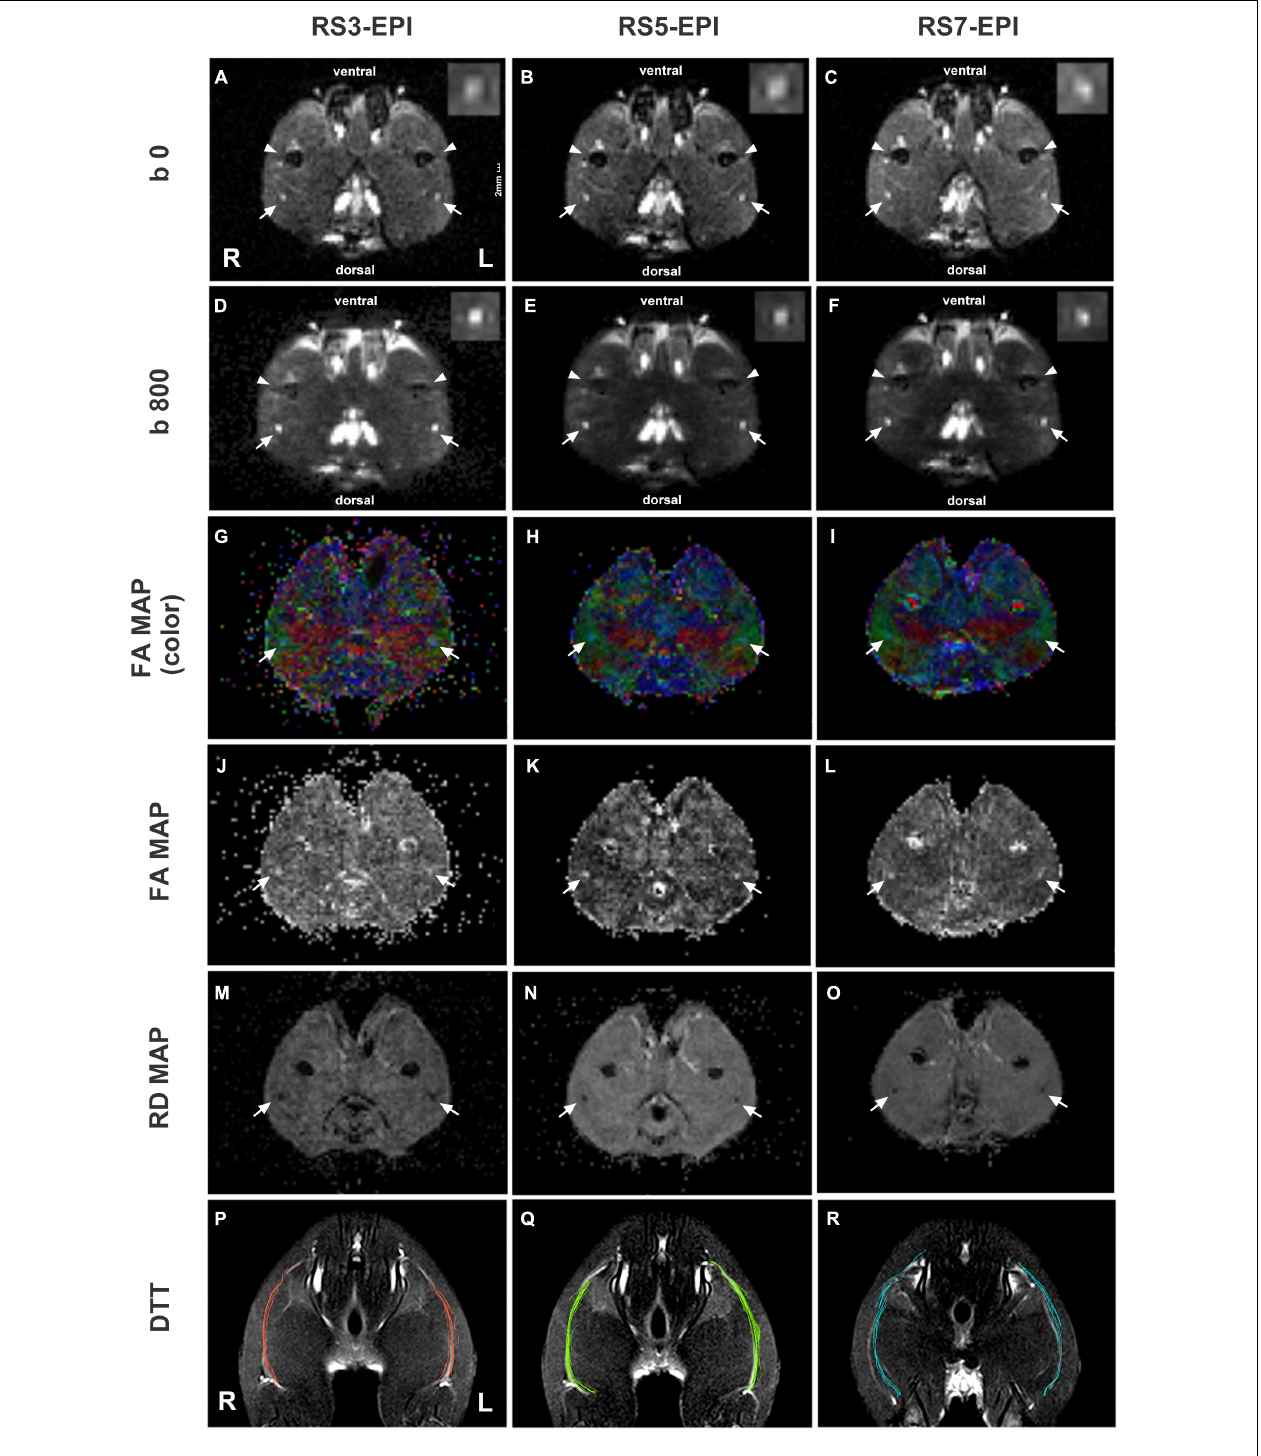
FIGURE 3 | DTI images and DTT of sciatic nerves for RS3-EPI, RS5-EPI, and RS7-EPI. The RS5-EPI images displayed clearer nerve boundaries and minimum nerve distortion, while RS7-EPI showed severe nerve distortion and blurred nerve boundaries (A–F) . The FA maps (G–L) and RD maps (M–O) showed blurred boundaries of RS3-EPI due to poor SNR (G,J,M) and of RS5-EPI due to severe nerve distortion (I,L,O) . The ventral and dorsal margin artifacts and background noise for RS3-EPI were more pronounced (D,G,J) . DTT: RS5-EPI DTI can generate more fibers than RS3-EPI and RS7-EPI and display nerve fibers with a more condensed bundle and realistic architecture (P–R) . Conversely, fibers generated by RS3-EPI and RS7-EPI DTI were sparse and discrete, some of which were deviated and in random order. R: right hind limb; L: left hind limb. Scale: 2 mm.